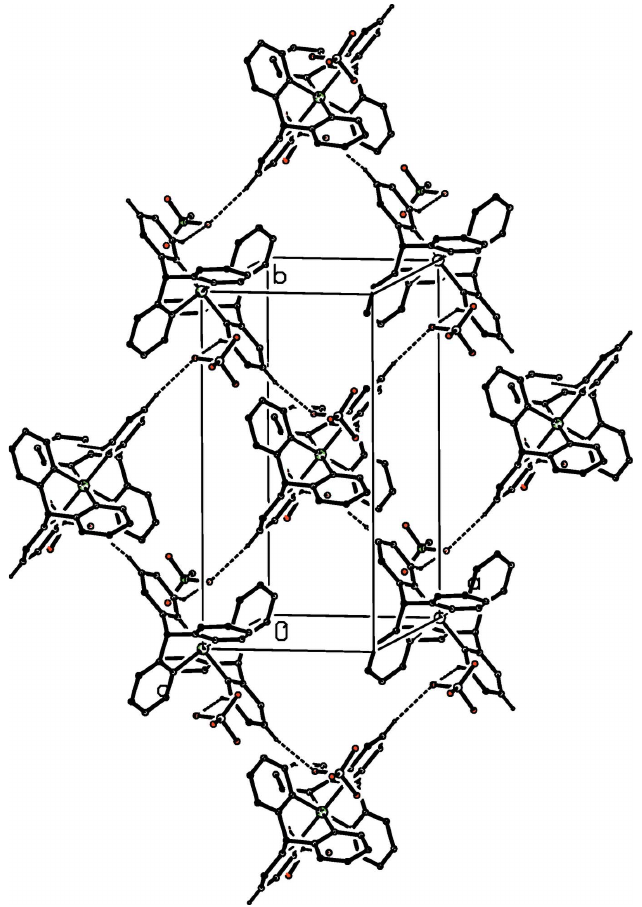
Figure 4 Part of the crystal structure of compound (I), showing the formation of a hydrogen-bonded sheet lying parallel to (101). For the sake of clarity, only the major disorder component of the anion is shown and the H atoms not involved in the motif shown have been